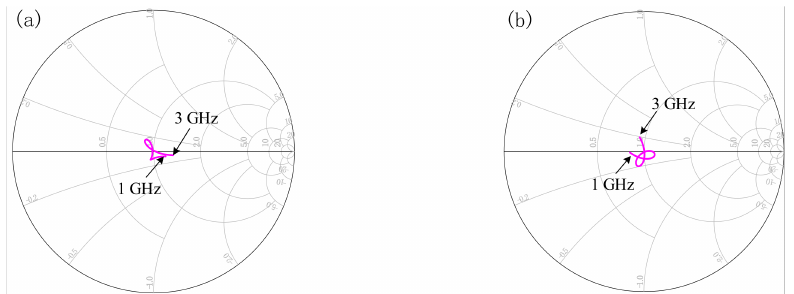
Figure 8. The impedance tracks. ( a ) output matching network; ( b ) input matching network.